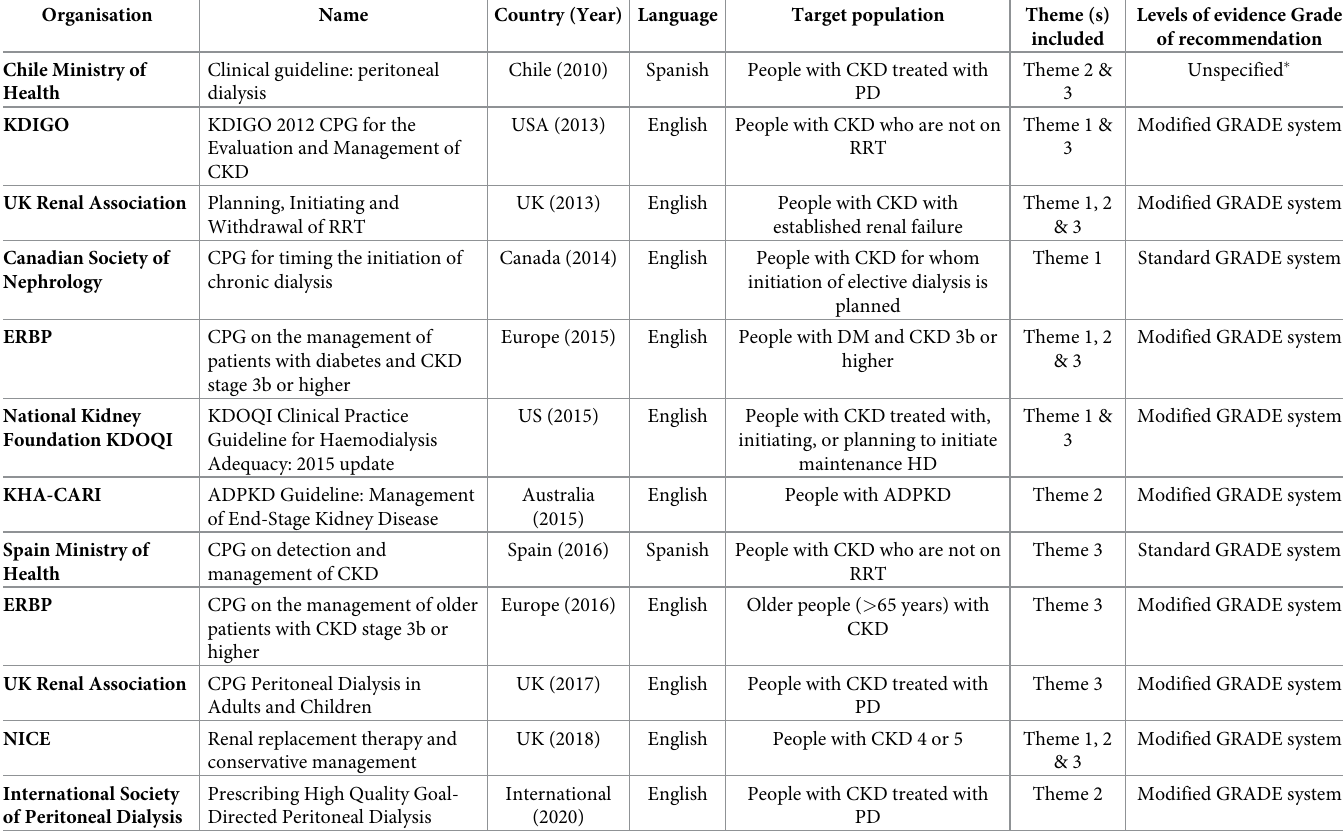
Table 1. Characteristics of included high-quality clinical practice